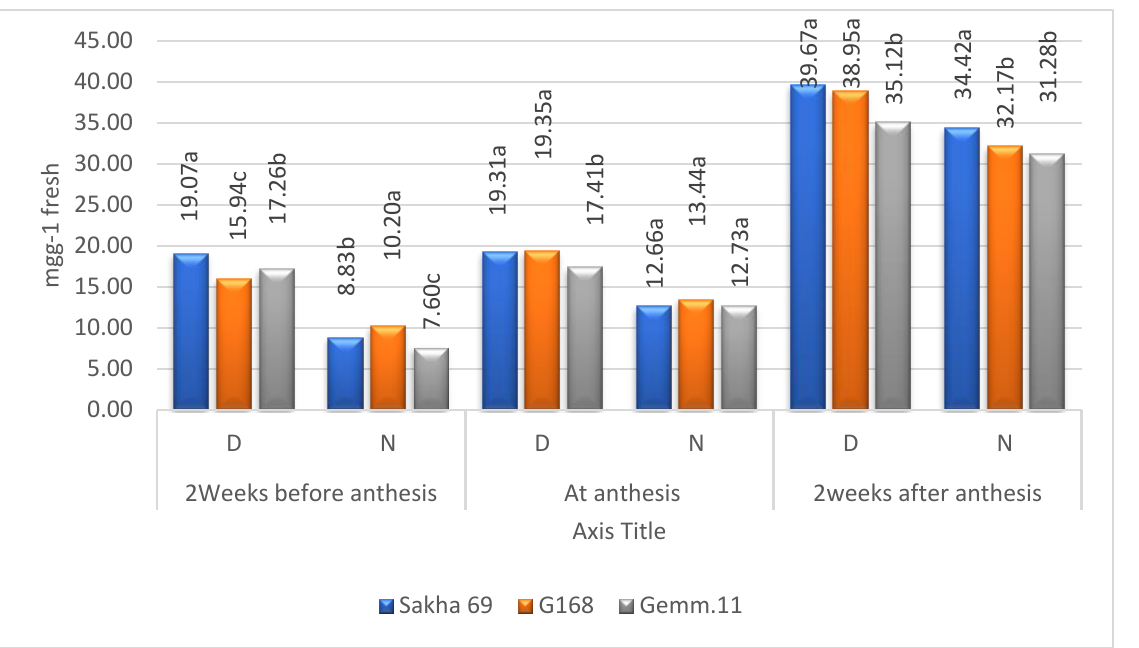
Figure 4. Combined means of soluble sugar for cultivars under drought stress (D) and irrigation (N); means followed by the same letter in each environment are not significant at the 0.05 level of probability according to LSD test.